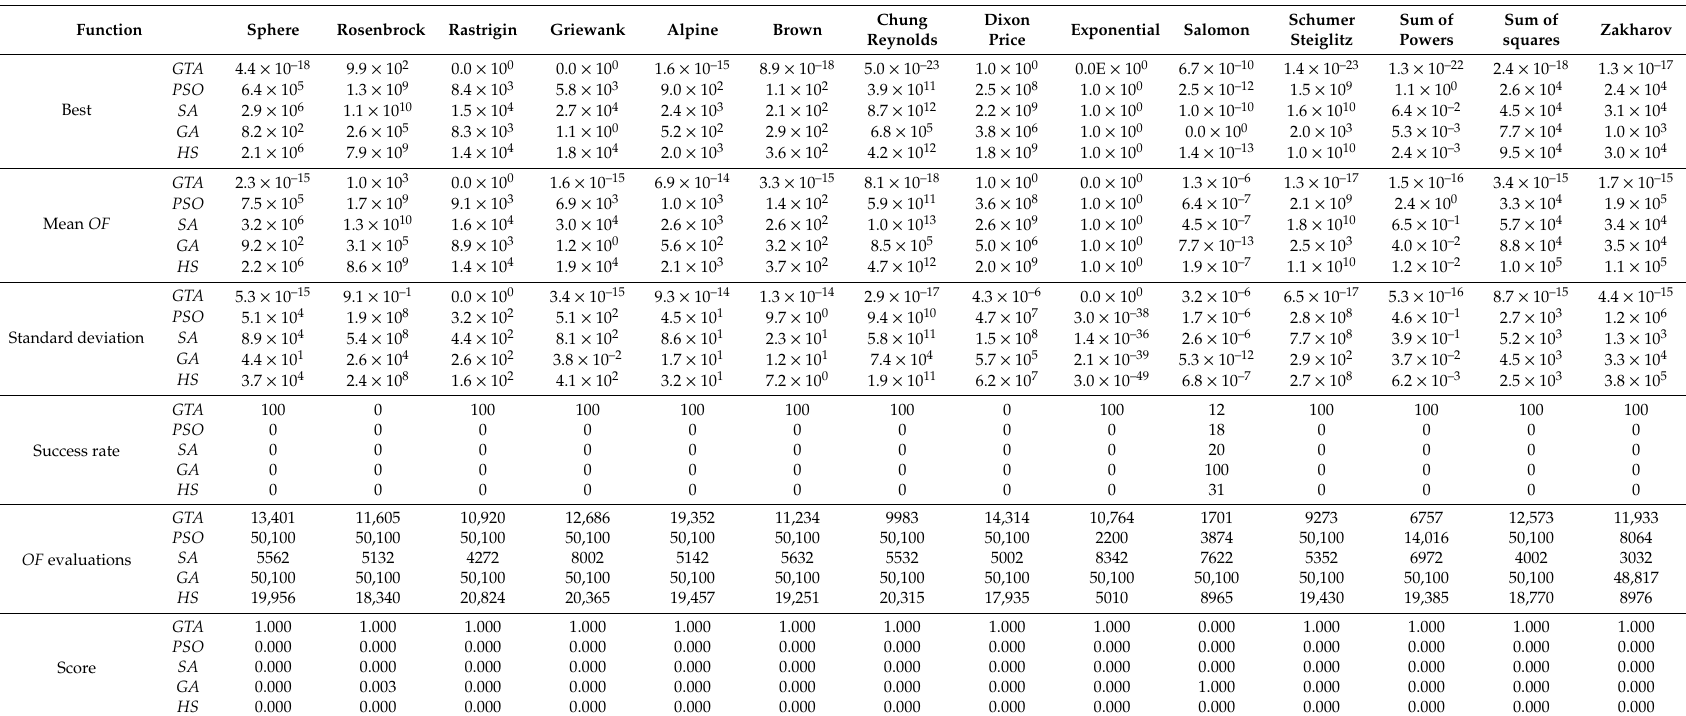
Table 3. Results of 100 runs with 1000